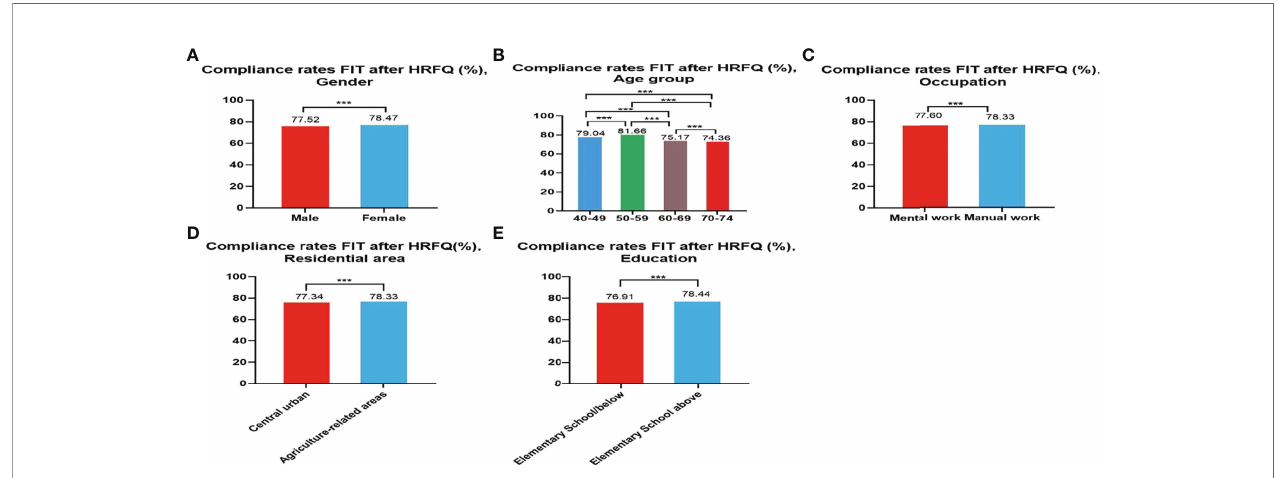
FIGURE 3 | Compliance results by gender (A) , age group (B) , occupation (C) , residential area (D) , education (E) of FIT after HRFQ. ***There are signi fi cant differences in detection rates between the different screening methods.